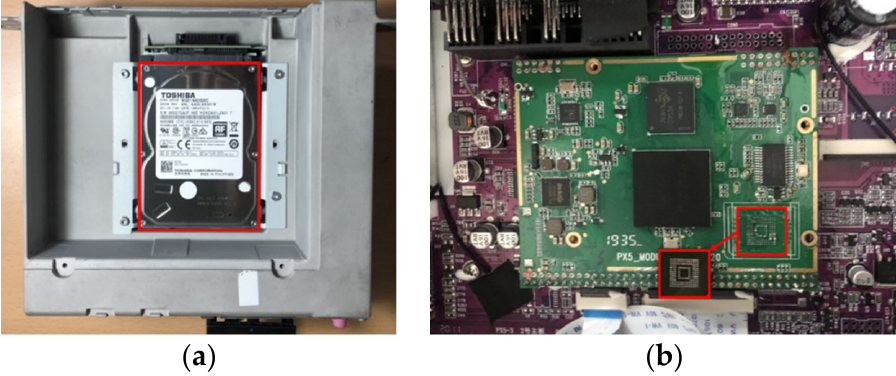
Figure 7. The red frames indicate the storage of the IVI system: ( a ) HDD acquired from BMW NBT HU EVO, ( b ) NAND flash acquired from Belsee Best Aftermarket Auto.